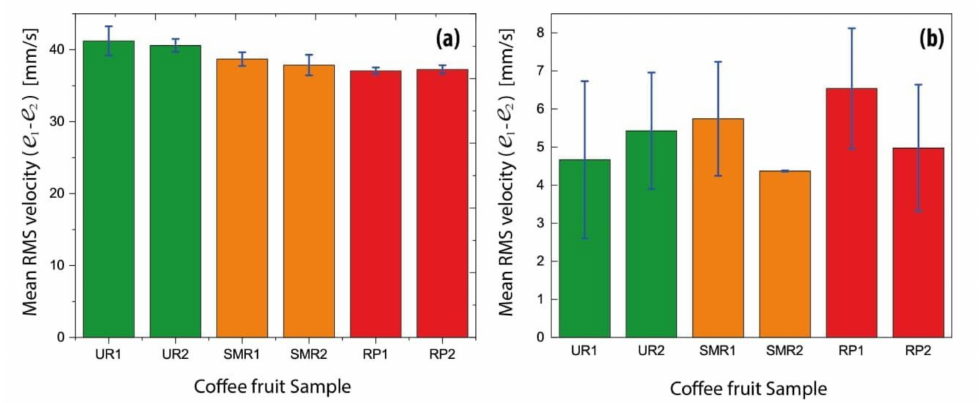
Figure 7. Mean RMS of velocity measurements in directions e 1 and e 2 . ( a ) 10 to 100 Hz. ( b ) 100 to 1000 Hz.